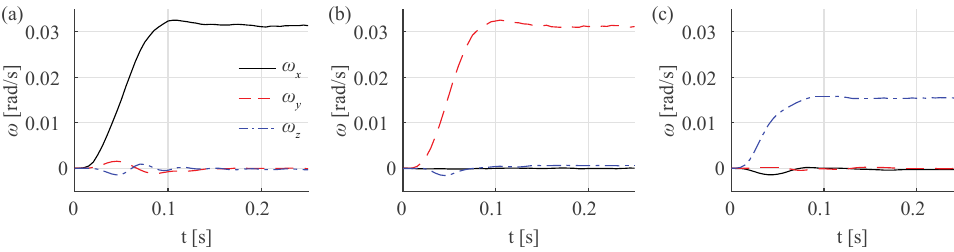
Figure 6. Step input response of the system. The step inputs are ( a ) U sp = [1, 0, 0], ( b ) U sp = [0, 1, 0] and ( c ) U sp = [0, 0, 1], respectively. The black solid line, red dashed line and blue dash-dotted line are the angular velocity ω in x -axis, y -axis and z -axis respectively.